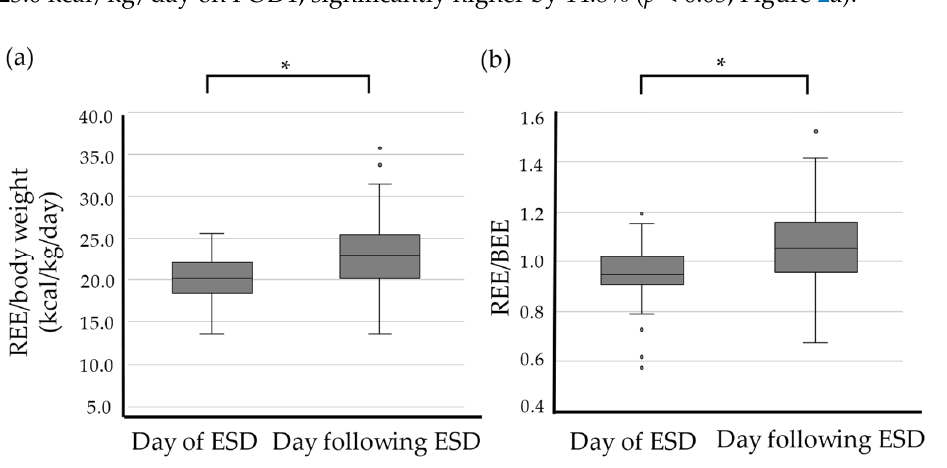
Figure 2. The changes of REE/body weight ( a ) and REE/BEE ( b ). Data are expressed as median (range). * p < 0.05: compared with the value on the day of ESD. ESD: endoscopic submucosal dissec- tion; REE: resting energy expenditure; BEE: basal energy expenditure.